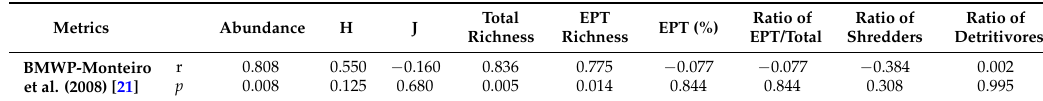
Table 6. Correlations of BMWP with other studied biotic metrics based on macroinvertebrate fauna of nine streams of Taquaruçu Grande river basin, State of Tocantins,